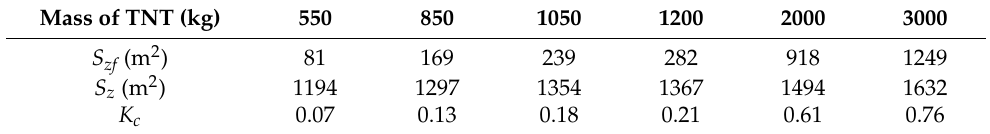
Table 5. The damage degree of the arch structure of the dam suffered an underwater contact explosion. Mass of TNT (kg) 550 850 1050 1200